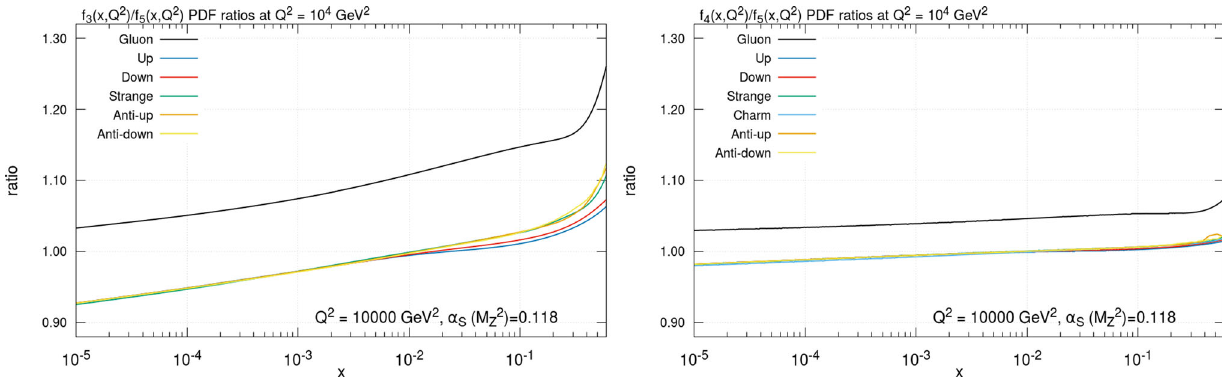
Fig. 27 The ratio of the different fixed flavour PDFs to the standard 5 flavour PDFs at NNLO and at Q 2 = 10 4 GeV 2 . The 3 and 4 flavour schemes are show in the left and right plots respectively